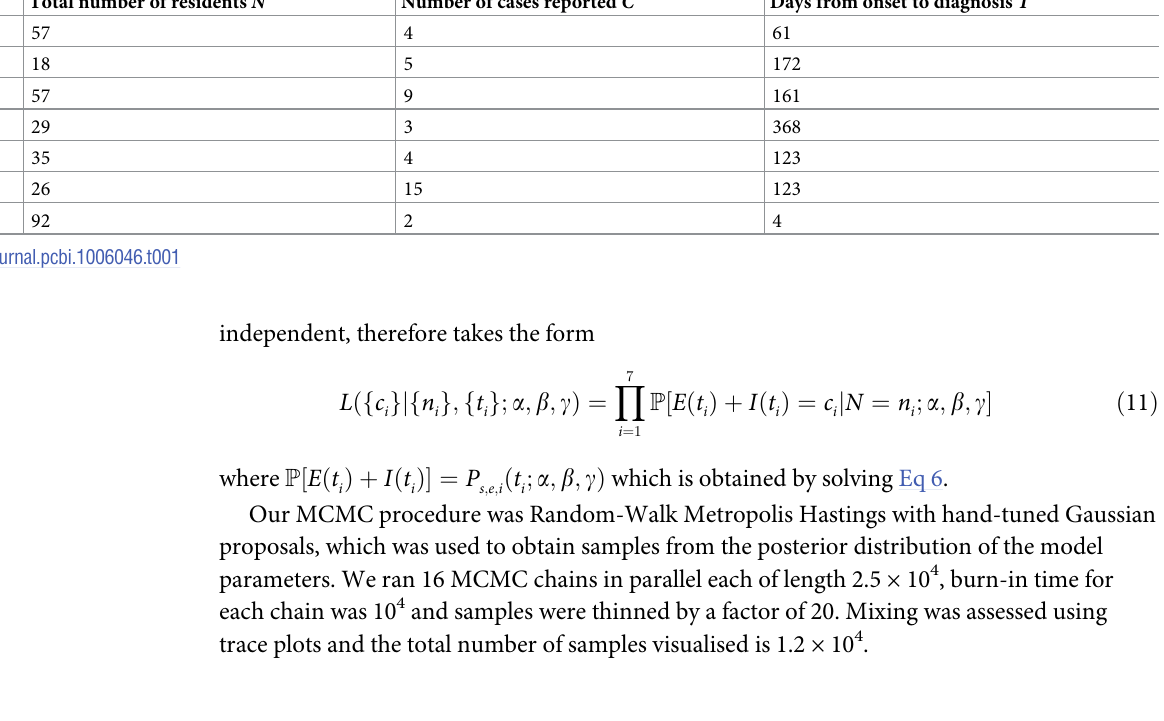
Table 1. Scabies data among residents in seven carehomes with the total number of residents, number of reported cases and time to diagnosis. Data from [28].